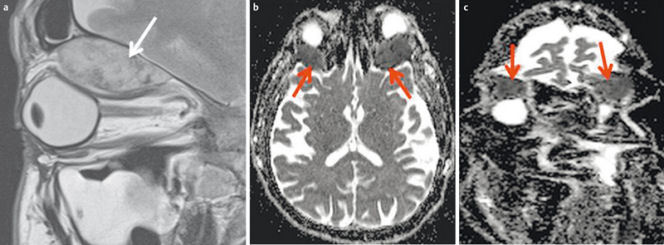
44-year-old patient with new onset of diplopia and progressive loss of vision in both eyes.a) T2w images demonstrate a subperiostal inhomogeneous lesion with smooth margins.b) Axial ADC map demonstrates bilateral lesions (arrow). ADC-value is >1.0×10–3 mm2/s on both sides, indicating a benign lesion (histologically proven hematoma due to coagulopathy).c) Coronal ADC map with significant distortion artifacts due to air-tissue interfaces and involuntary eye movement.